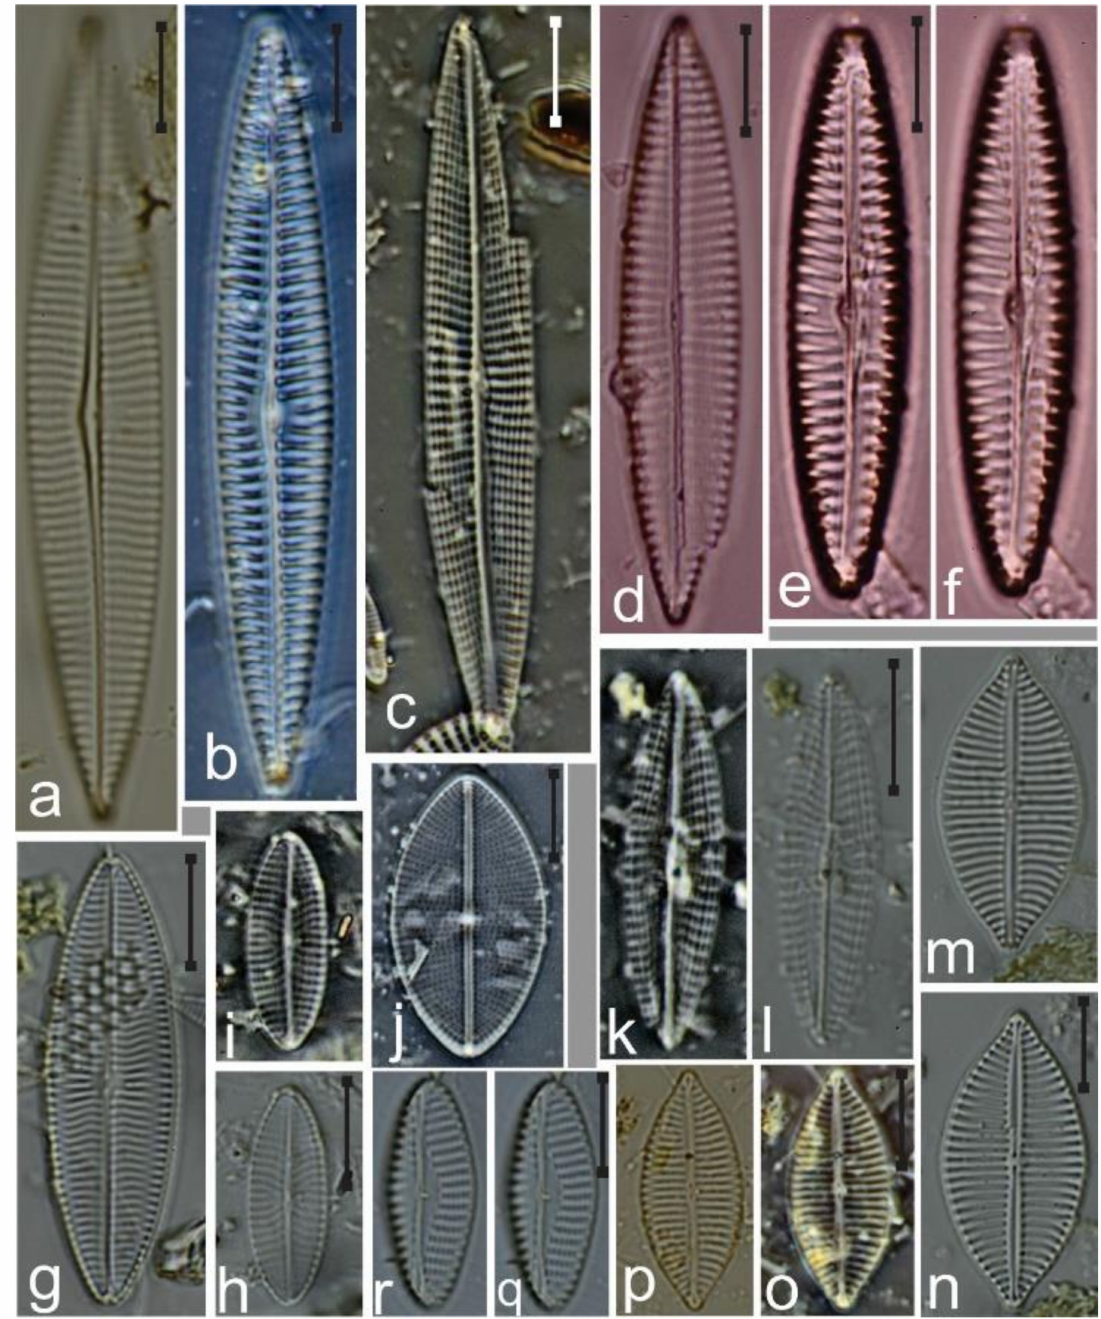
Figure 31. ( a ) Navicula transitans ; ( b ) N. pennata ; ( c , k , l ) N. pavillardii ; ( d ) N. arenaria var. rostellata ; ( e , f ) N. cancellata ; ( g ) N. johannrossii ; ( h , i ) N. lusoria ; ( j ) N. cluthensis ; ( m – p ) N. diversistriata ; ( q , r ) N. valida var. minuta . Scale bar = 10 µ